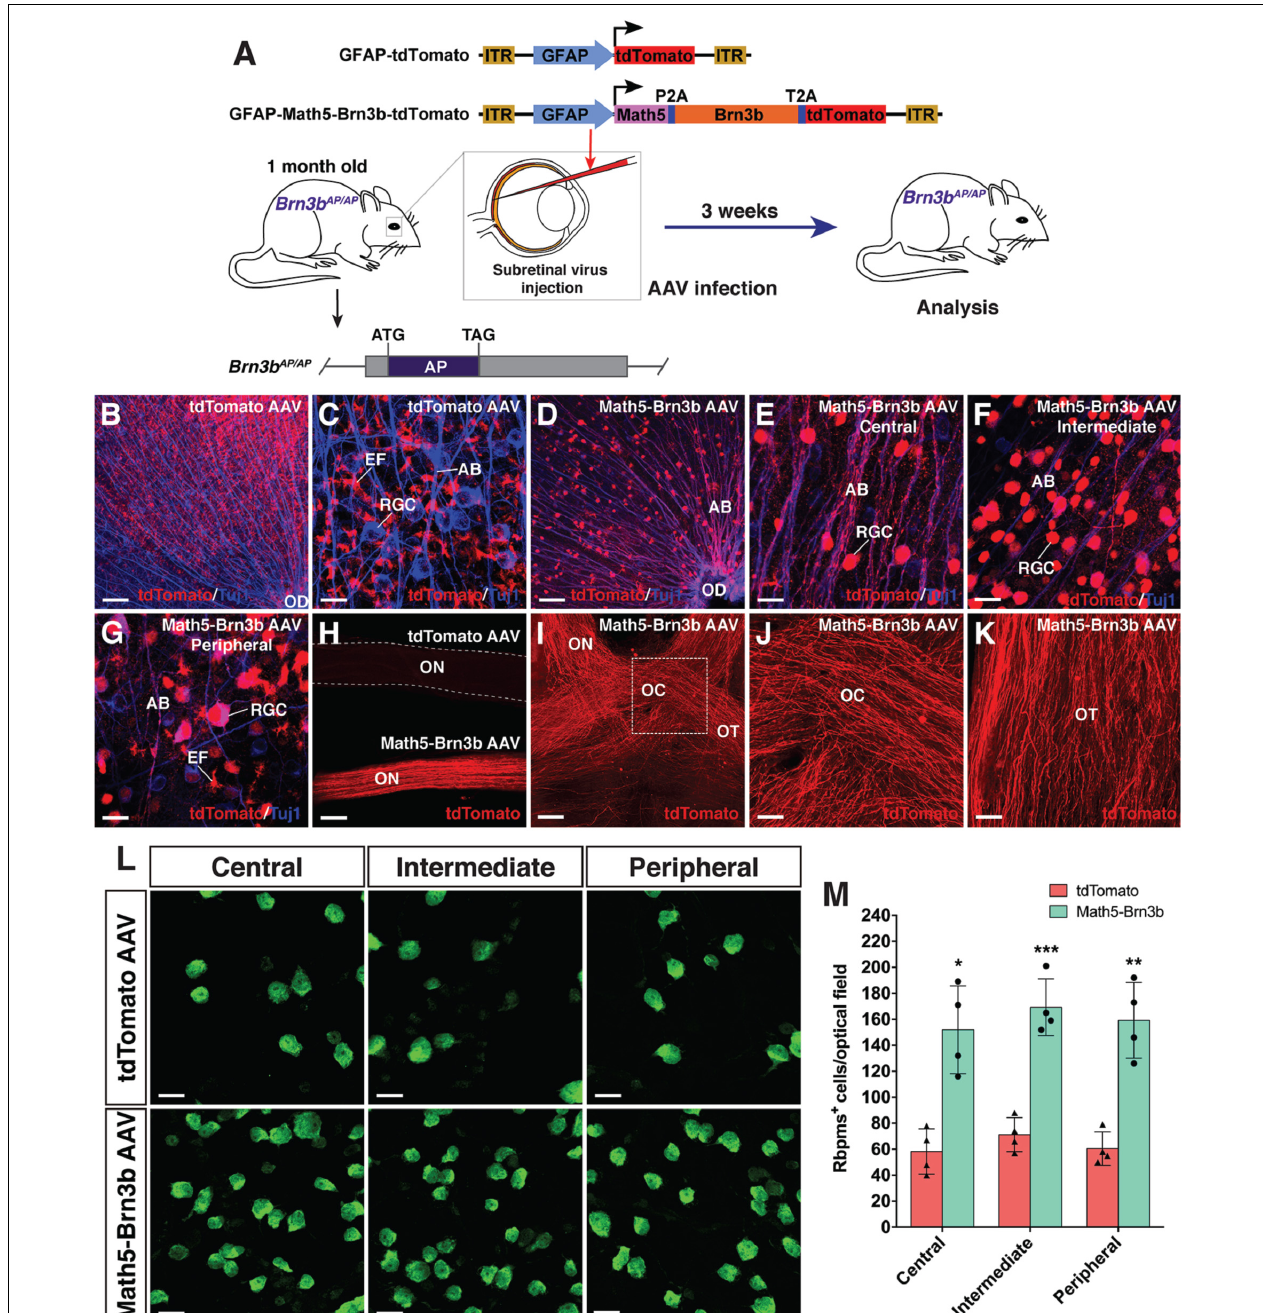
FIGURE 6 | RGC regeneration in Brn3b AP / AP mice. (A) Schematic of the AAV constructs and infection procedure to regenerate RGCs in Brn3b AP / AP mice at 1 month of age. (B,C) Flat-mounts of Brn3b AP / AP retinas treated with GFAP-tdTomato AAVs were double-immunolabeled with anti-tdTomato and anti-Tuj1 antibodies. (D–G) Flat-mounts of Brn3b AP / AP retinas treated with GFAP-Math5-Brn3b-tdTomato AAVs were double-immunolabeled with anti-tdTomato and anti-Tuj1 antibodies. Shown in (E–G) are representative images from the central, intermediate and peripheral retinas, respectively. (H) The optic nerves from Brn3b AP / AP mice treated with GFAP-Math5-Brn3b-tdTomato AAVs were immunoreactive for tdTomato whereas those from Brn3b AP / AP mice treated with GFAP-tdTomato AAVs were not. (I–K) The optic nerves, optic chiasms and optic tracts from Brn3b AP / AP mice treated with GFAP-Math5-Brn3b-tdTomato AAVs were immunoreactive for tdTomato. Shown in (J) is a higher magnification view of the region outlined in (I) . (L) Flat-mounts of central, intermediate and peripheral Brn3b AP / AP retinas treated with GFAP-tdTomato or GFAP-Math5-Brn3b-tdTomato AAVs were immunostained with an anti-Rbpms antibody. (M) Quantification of Rbpms+ cells in central, intermediate and peripheral Brn3b AP / AP retinas treated with GFAP-tdTomato or GFAP-Math5-Brn3b-tdTomato AAVs. Data are presented as mean ± SD ( n = 4). Asterisks indicate significance in unpaired two-tailed Student’s t -test: * p < 0.005, ** p < 0.001, *** p < 0.0005. AB, axon bundle; EF, MG endfoot; OC, optic chiasm; OD, optic disk; ON, optic nerve; OT, optic tract; RGC, retinal ganglion cell. Scale bars = 114 µ m (I) , 80 µ m (B,D,H) , 40 µ m (J,K) , 20 µ m (C,E–G,L) .